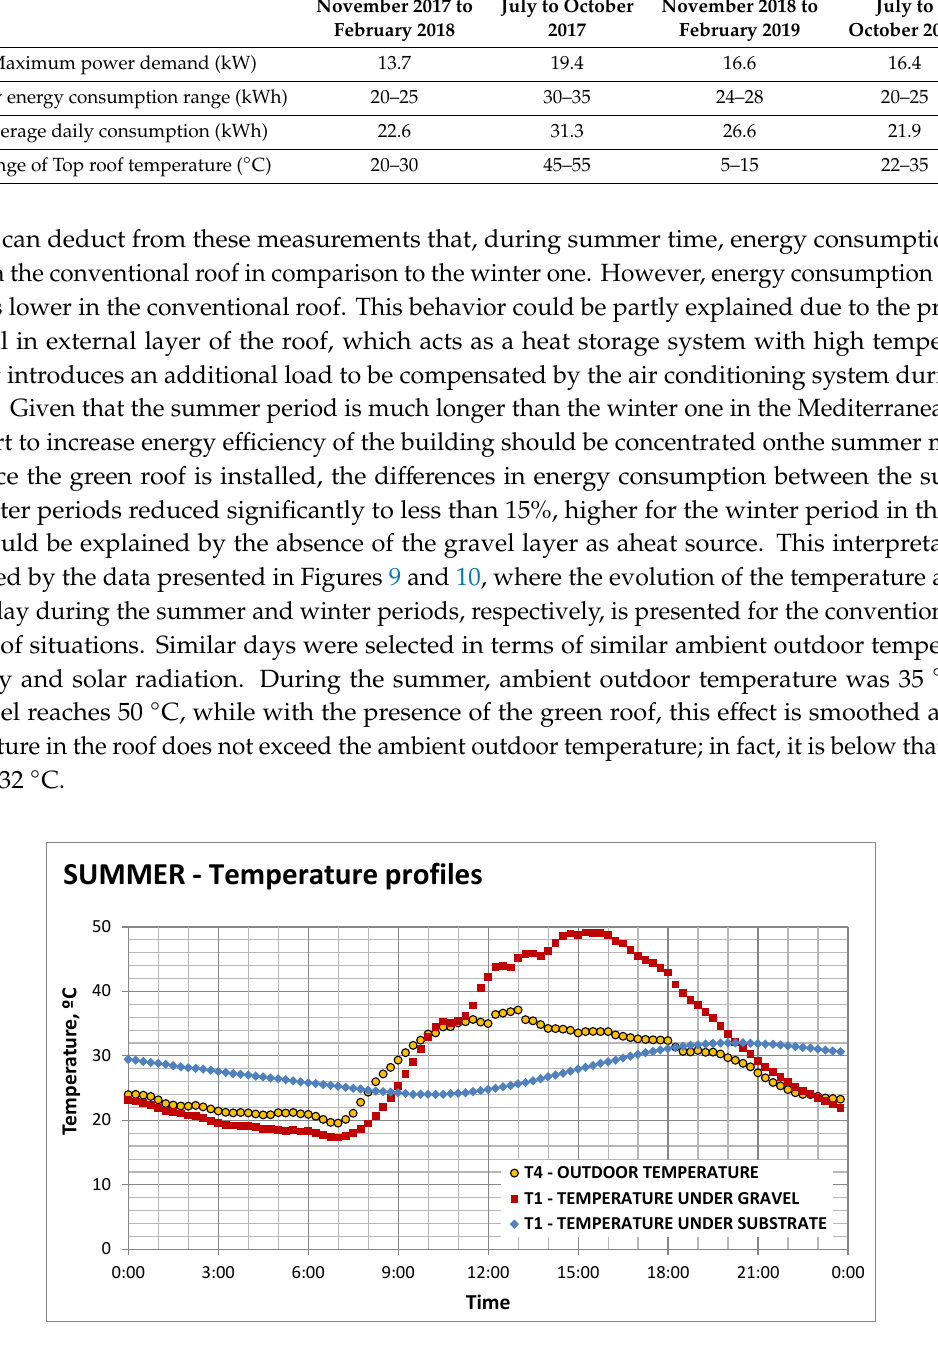
Table 2. Energy demand for conventional and green roof .